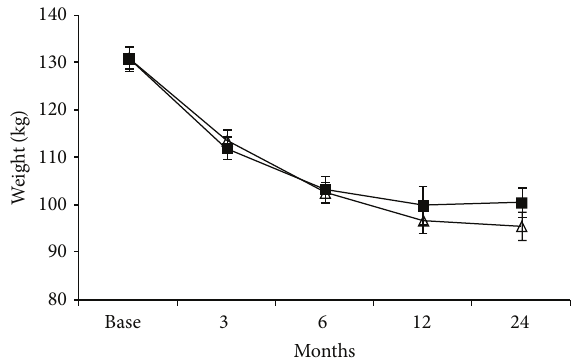
Figure 1: Overall changes in weight (mean ± SEM) in patients treated with bariatric surgery. ( Δ ) obese patients without diabetes; ( ◼ ) obese patients with type 2